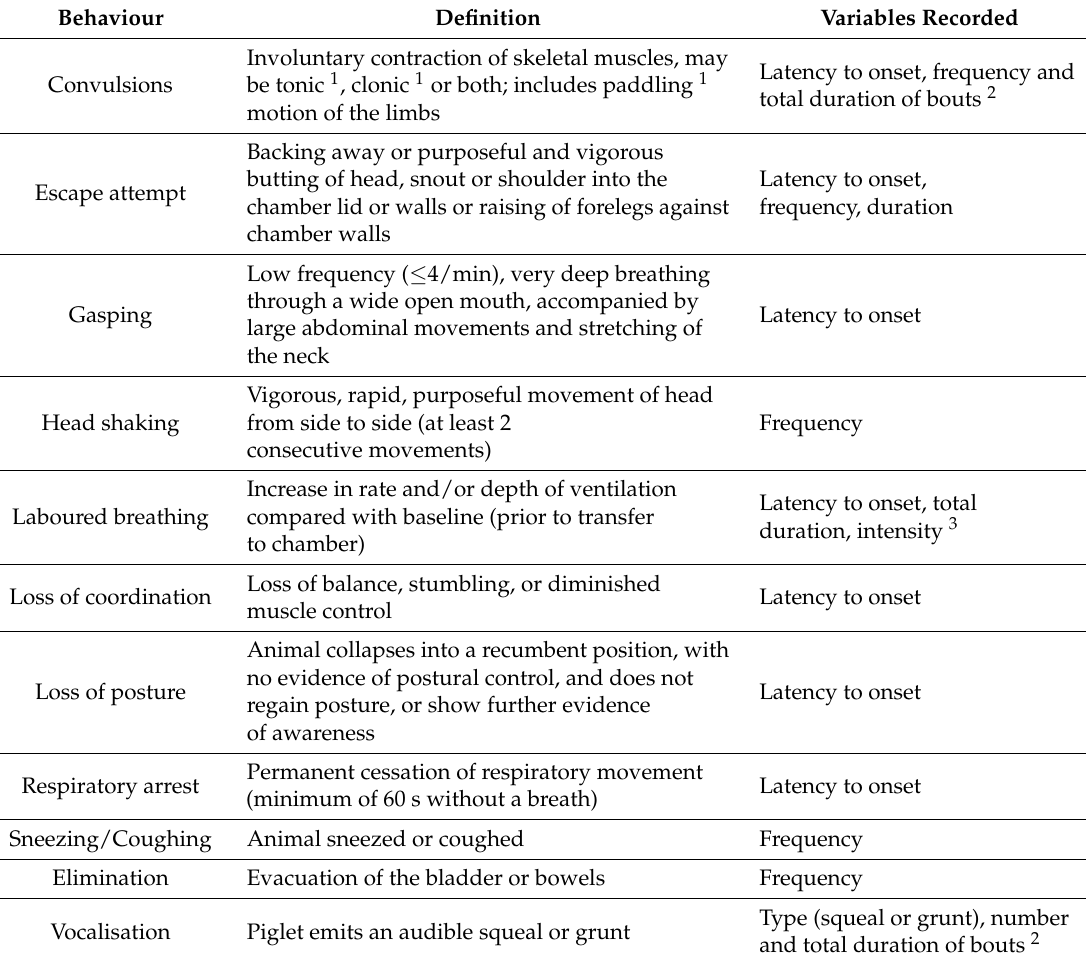
Table 1. Ethogram of piglet behaviour recorded during exposure to various